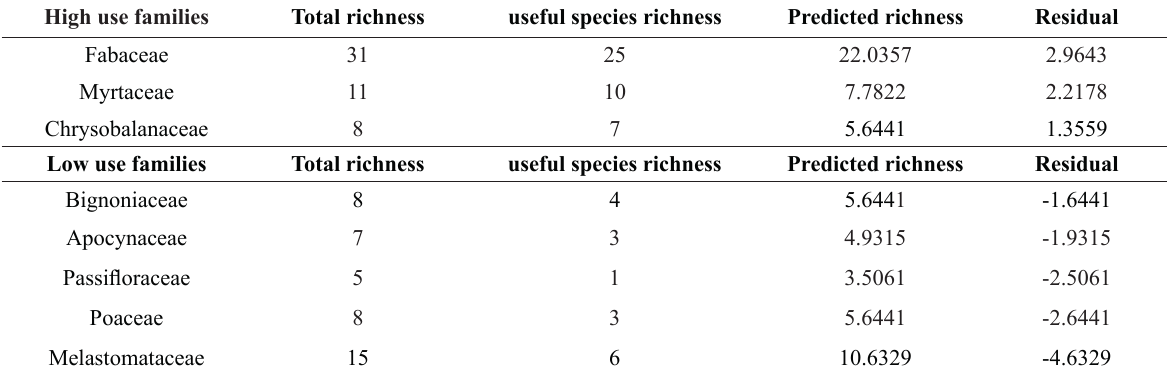
Residual data of families with higher and lower proportion useful species in